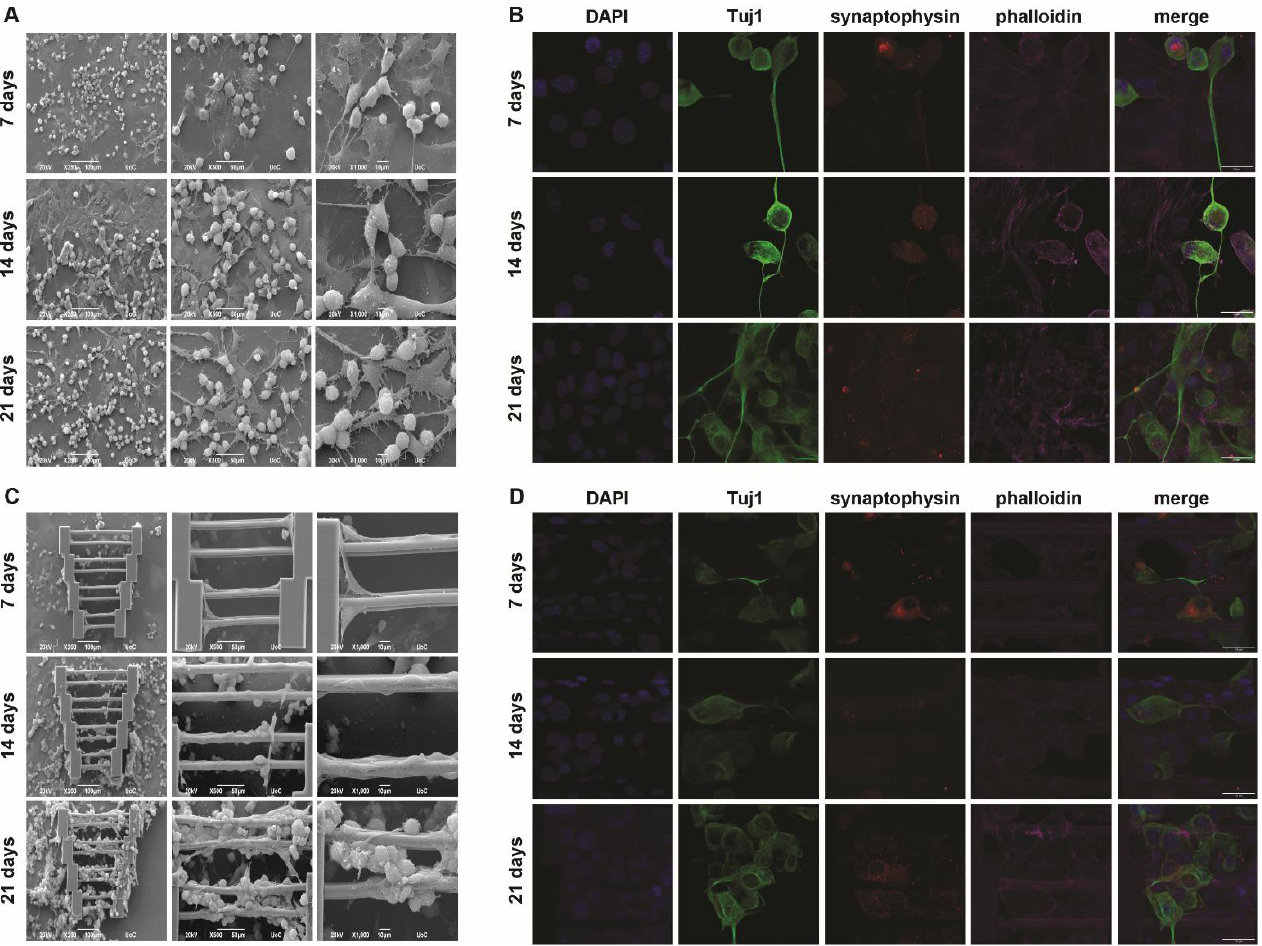
Figure 4. SW10/N2a co-cultures. Cultures on flat glass coverslips. SEM ( A ) and confocal ( B ) images show that SW10 cells attach to the glass substrate, whereas N2a cells attach both to the empty space of the glass substrate and on top of the SW10 cells. Some neurite growth towards random directions can also be observed. ( C , D ) Cultures on scaffolds. SEM ( C ) and confocal ( D ) images show that SW10 appear to attach first to the scaffolds and their behavior does not change drastically compared to mono-cultures, as they follow the guidewire orientation. N2a cells mostly attach to the SW10 cells. When N2a cells grow axons that are on the guidewires, the axons maintain guidewire directionality. Scale bars in panels ( B , D ) are given in the merged images and are 30 μm.